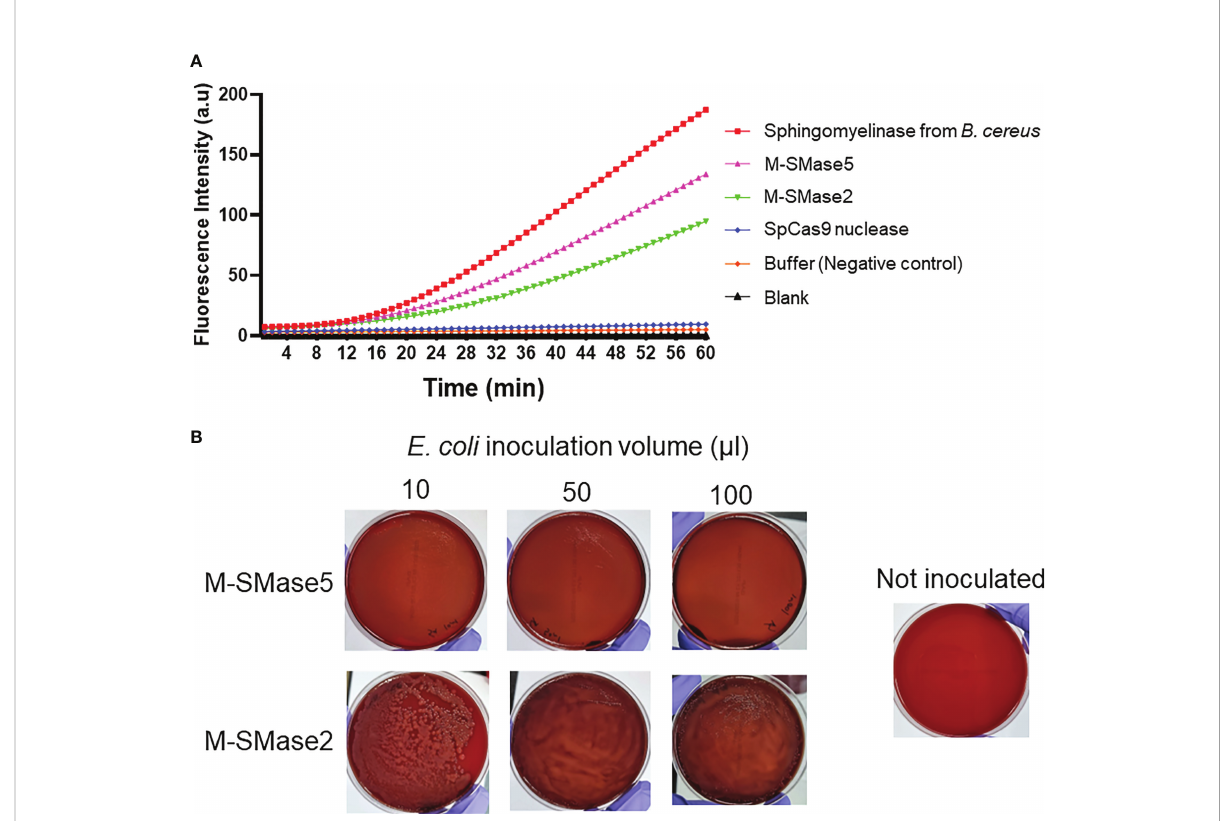
FIGURE 4 Biochemical and functional assessment of sphingomyelinase activities of predicted bacterial M-SMases. (A) 60-minute time course of fl uorescence signal intensity changes by the recombinant proteins in sphingomyelinase activity assays. The time-dependent changes in the fl uorescence intensities indicate sphingomyelinase activities. Recombinant M-SMase5 and M-SMase2 are putative sphingomyelinase proteins. Sphingomyelinase from Bacillus cereus ( B. cereus ) and Streptococcus pyogenes Cas9 (SpCas9) nuclease proteins are included as positive and negative controls, respectively. (B) Blood agar plate hemolysis assays to assess the hemolytic function of the putative sphingomyelinase proteins. E. coli cells that express recombinant M-SMase5 and M-SMase2 proteins were inoculated onto blood agar plate. The clearing of the red color indicates the extent of